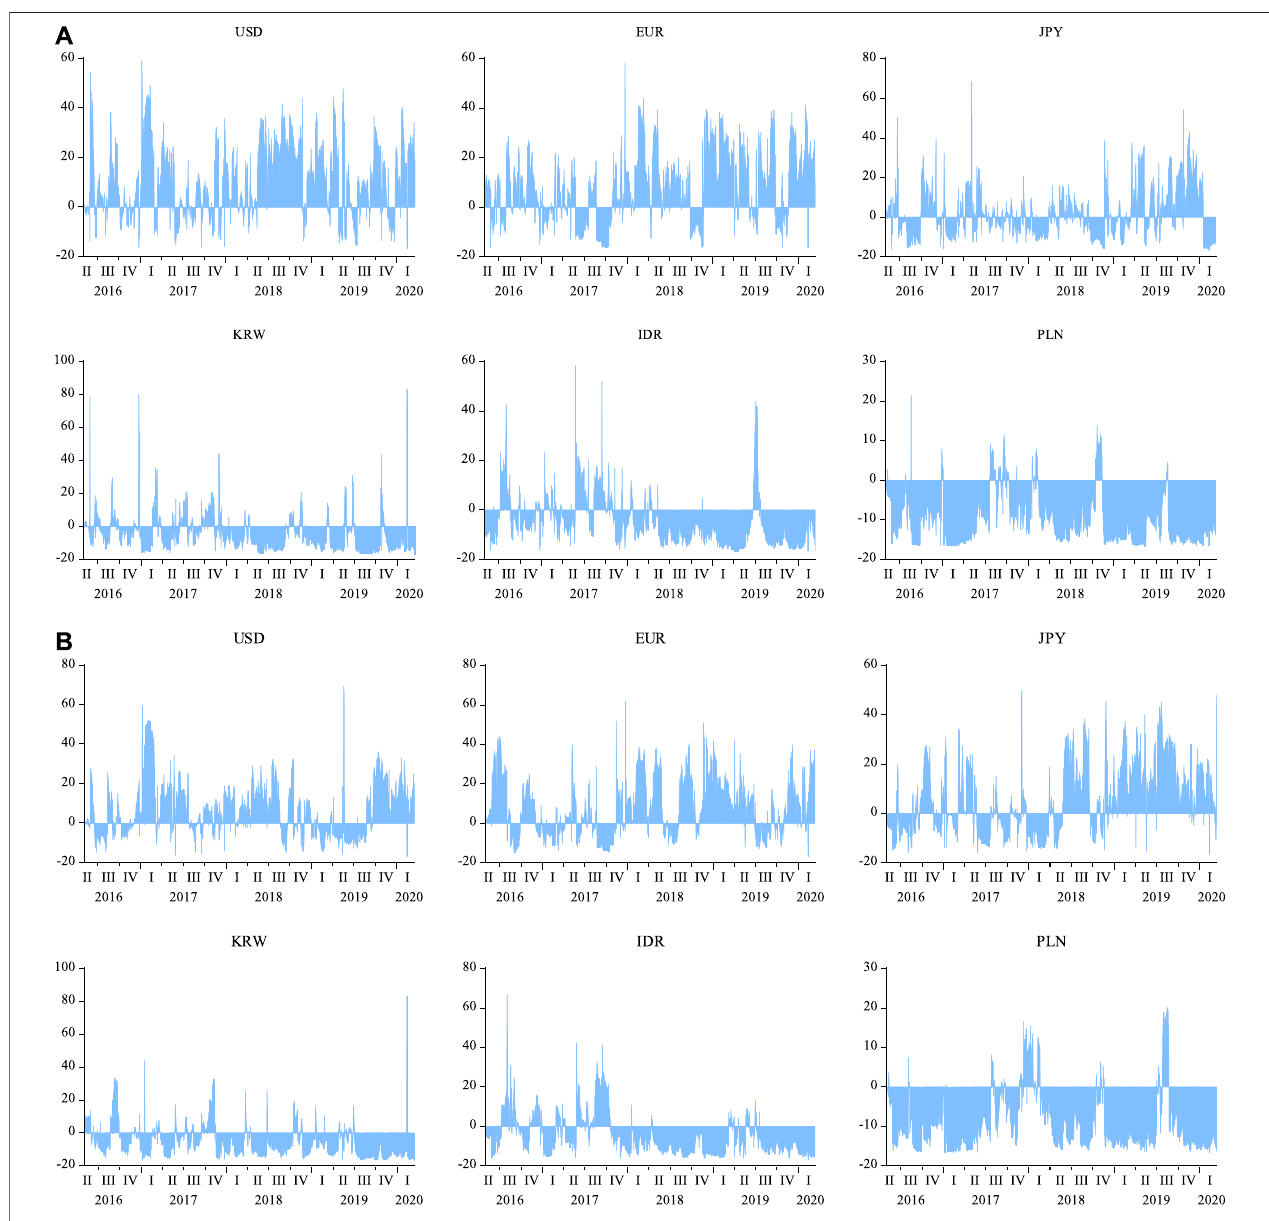
FIGURE4| DynamicnetspilloverbetweendifferentBitcoinmarkets. (A) standsforthedynamicspilloverforgoodvolatility; (B) reportsthedynamicspilloverforbad volatility.